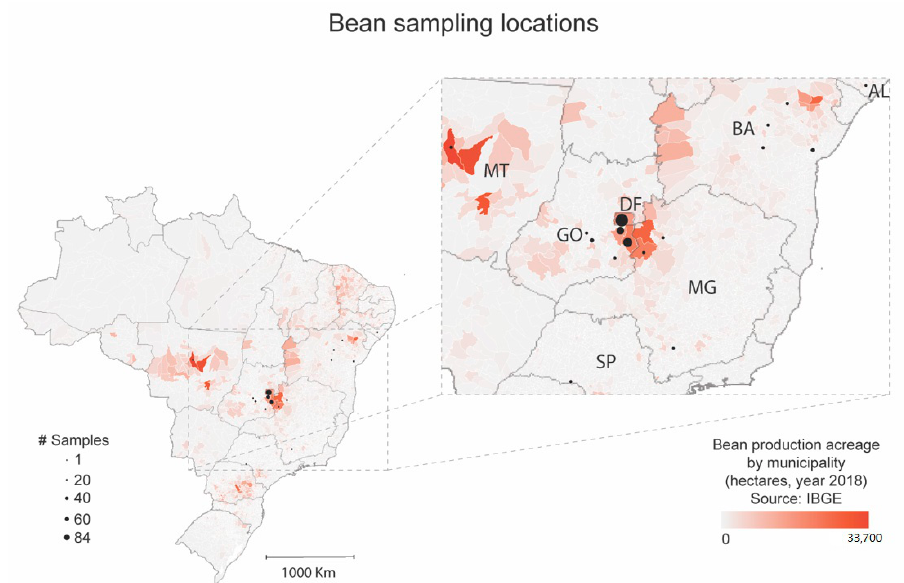
Figure 2. Summary of the distribution of the bean sampling locations at Alagoas (AL), Bahia (BA), Goiás (GO), Minas Gerais (MG), Mato Grosso (MT), São Paulo (SP) states and Distrito Federal (DF). Each municipality was colored in red according to the bean planted area (in hectare), obtained from the Brazilian Institute of Geography (https://www.ibge.gov.br/) [10]. The black circles represent the sample sites, and their size is proportional to the number of collected plants. The samples were collected between 2007 and 2018.